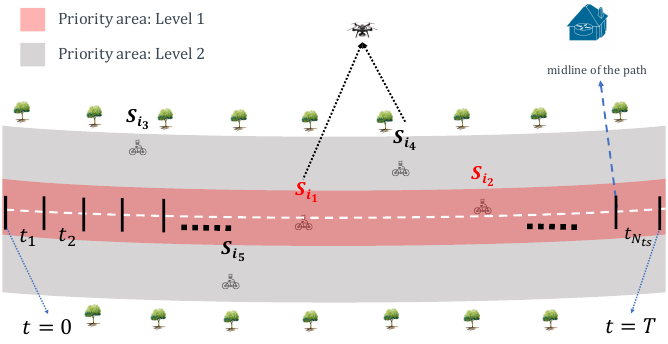
Figure 3. An illustration of studied